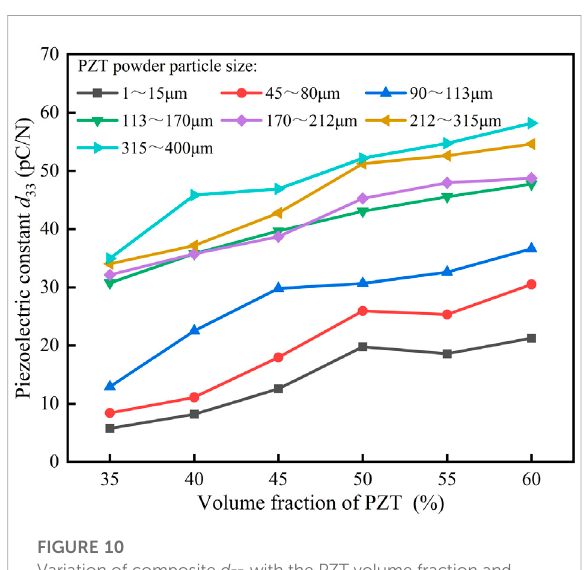
FIGURE 10 Variation of composite d 33 with the PZT volume fraction and powder